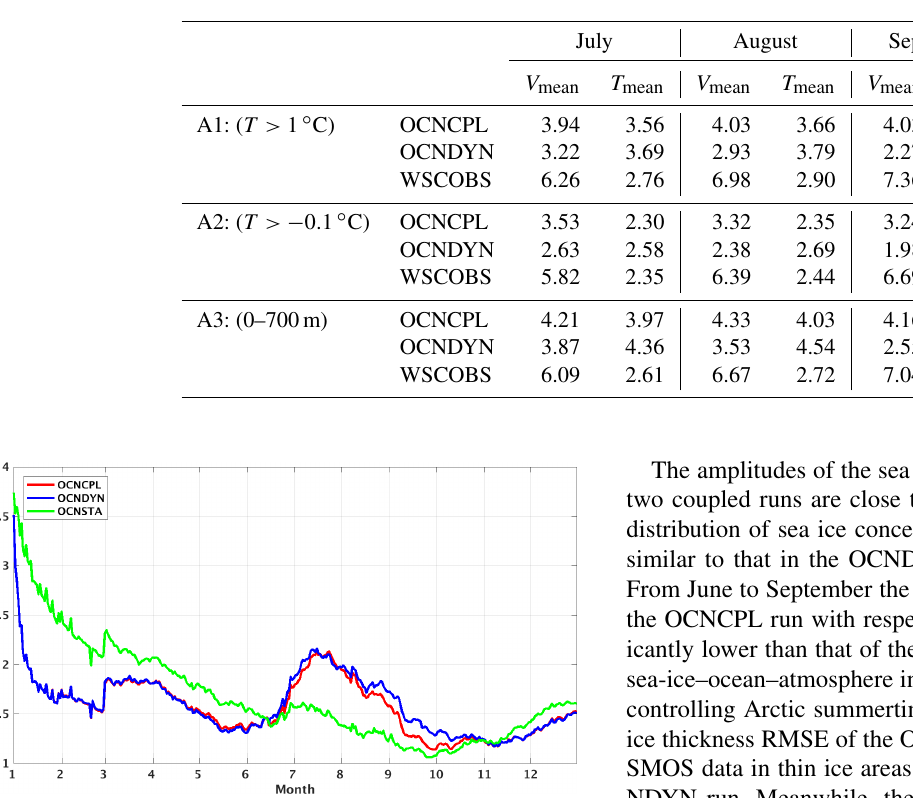
Table 4. Monthly mean northward cross-section velocity (cm/s) and temperature ( ◦ C) averaged between 5 and 8 ◦ 40 (cid:48) E at 78 ◦ 50 (cid:48) N in Fram Strait. A1 represents algorithm 1, in which values are calculated from sea water with potential temperature higher than 1 ◦ C. A2 represents algorithm 2, in which values are calculated from sea water with potential temperature higher than − 0.1 ◦ C. A3 represents algorithm 3, in which values are calculated from sea water with depth shallower than 700m. The observations are averaged between 1998 and 2003. WSCOBS: West Spitsbergen Current Observation.